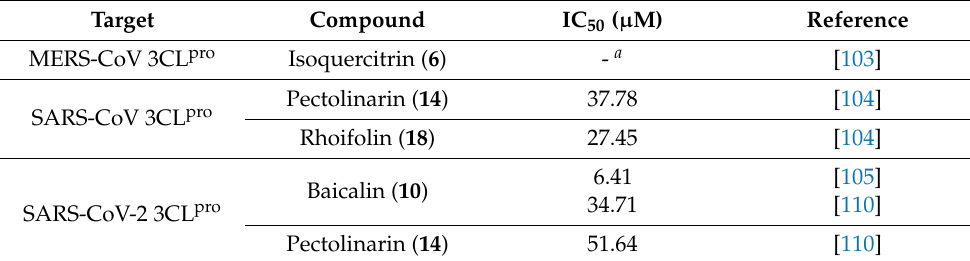
Table 2. Anti-coronaviral activity of glycosyl